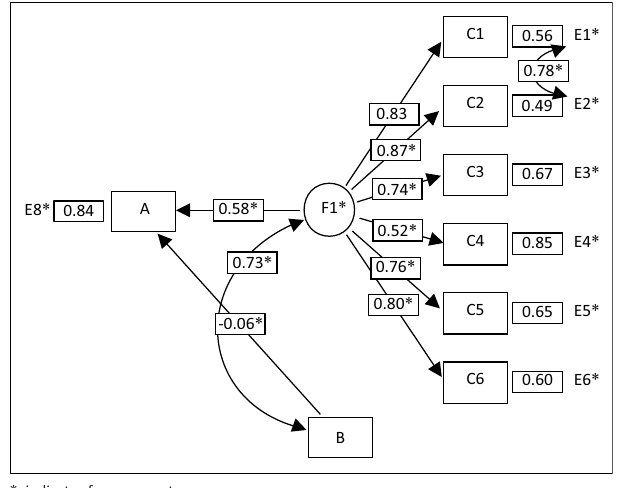
FIGURE 5: Higher-order structural model of the Experience of Work and Life Circumstances Questionnaire based on the sample data ( N = 217).